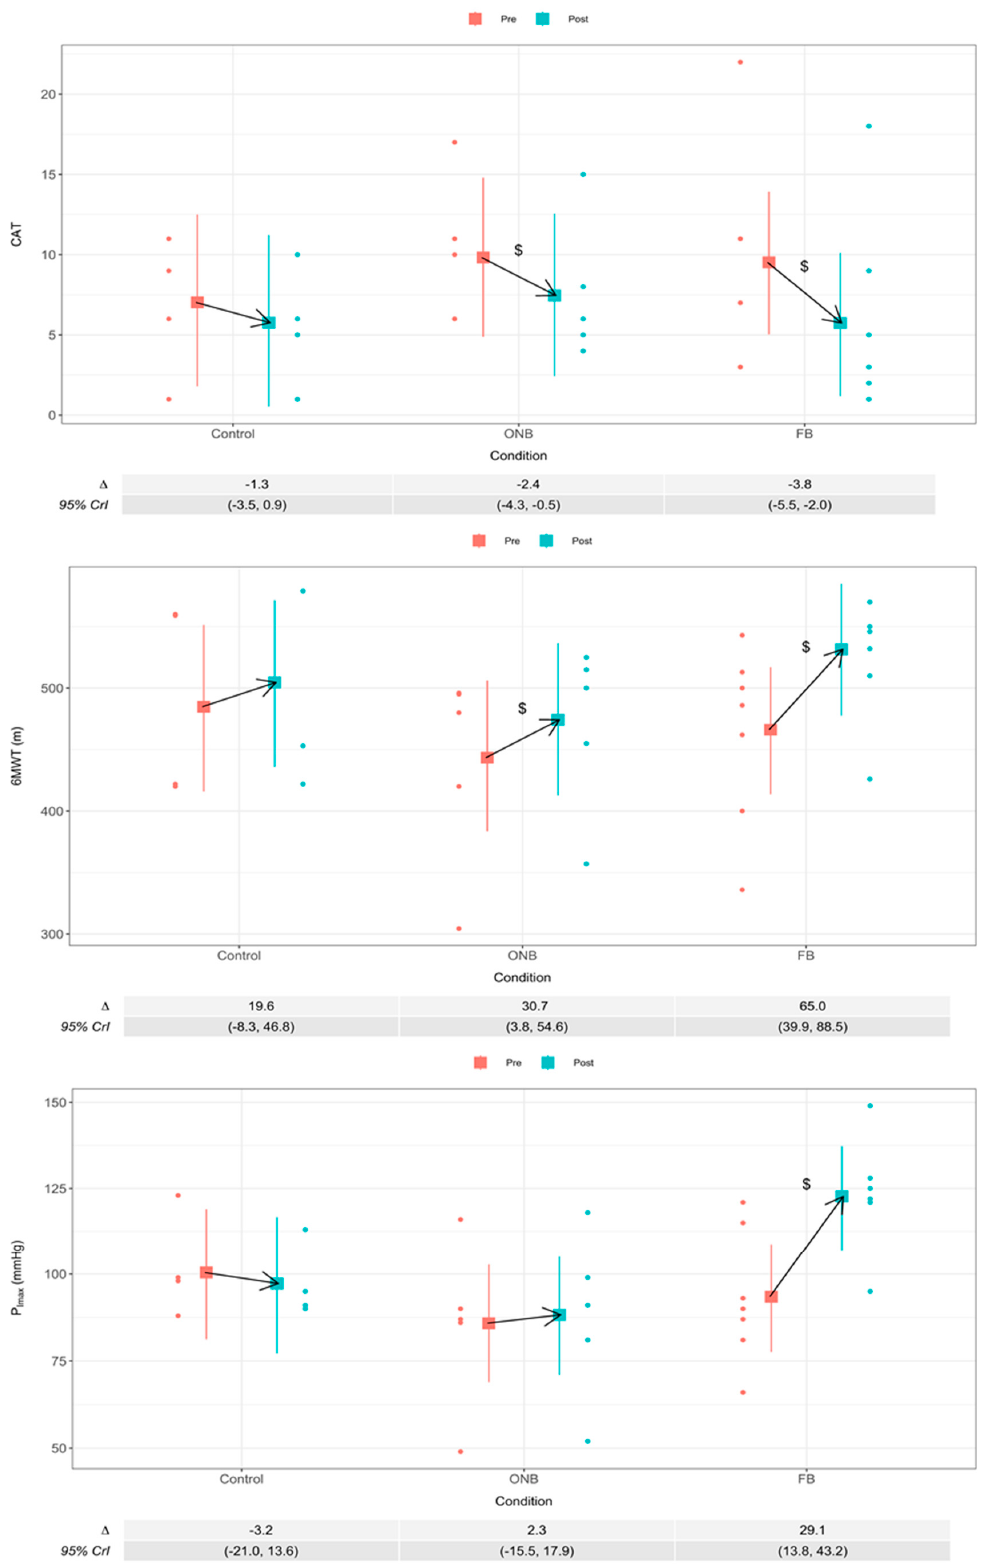
Figure 3. Mean di ff erence ( ∆ ) with 95% credible intervals (95% CrI) from pre to post-training in the CAT, 6MWT and P Imax . $ 95% CrI does not include 0 for the di ff erence between pre- and